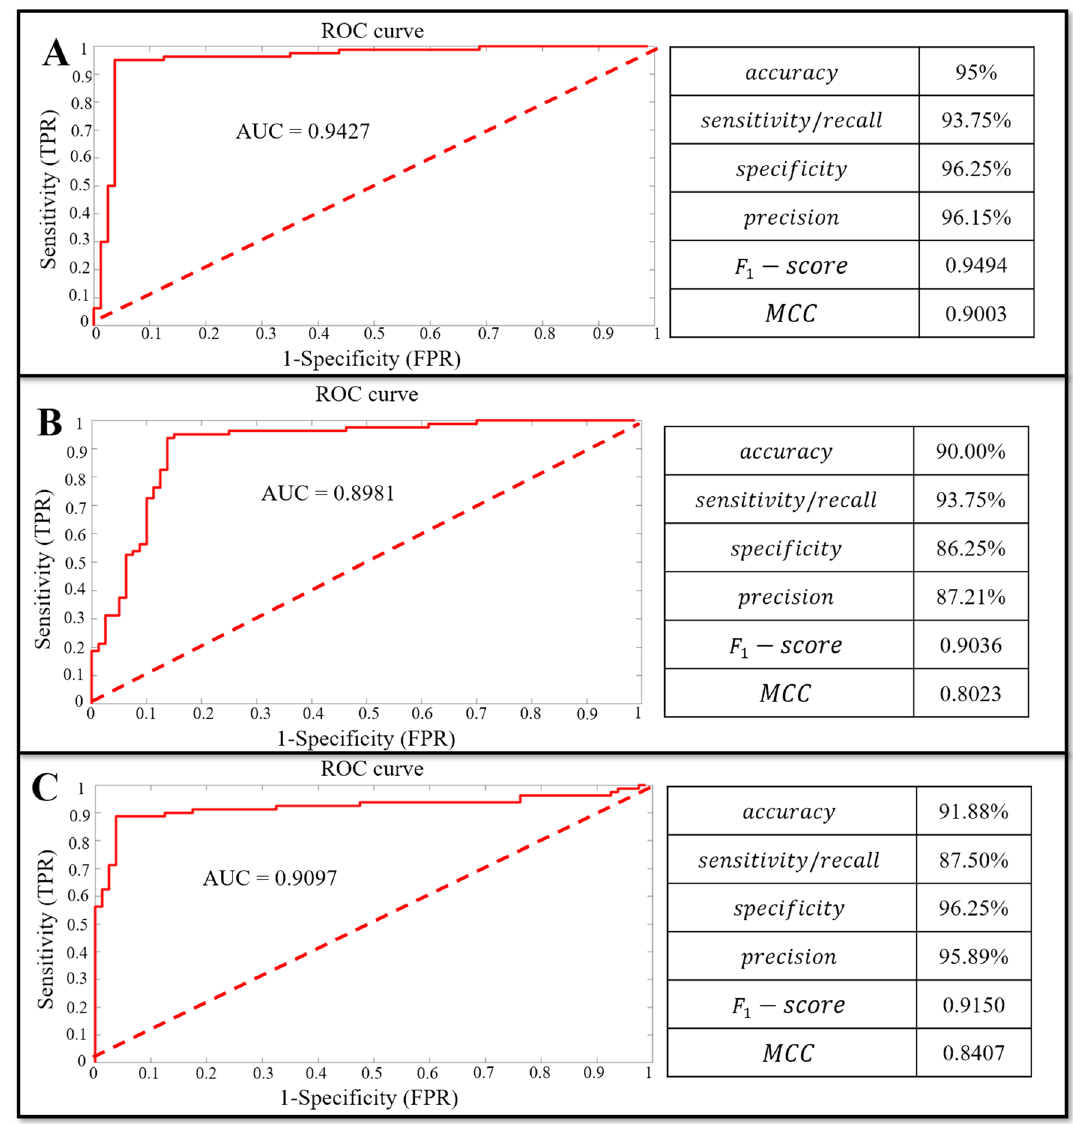
Figure 1. The classifier of the DNN models based on the matrices M , M kinematics , M kinetics . ( A ) The classifier of the DNN models based on the matrices M . ( B ) The classifier of the DNN models based on the matrices M kinematics . ( C ) The classifier of the DNN models based on the matrices M kinetics . ROC: Receiver Operating Characteristic; AUC: Area Under the ROC Curve; MCC: Matthews Correlation Coefficient; TPR: True Positive Rate; FPR: False Positive